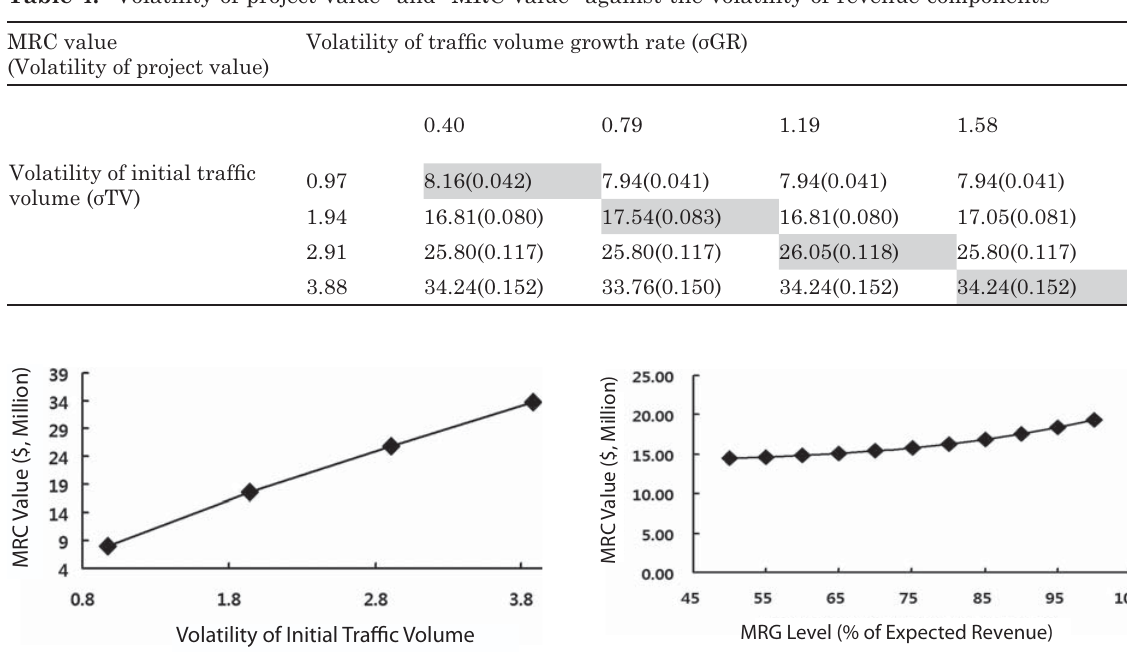
Figure 3. Sensitivity of the MRC value to